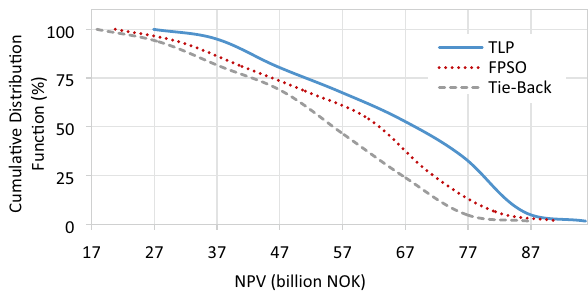
Fig. 9 Decision tree diagram for costs uncertainty